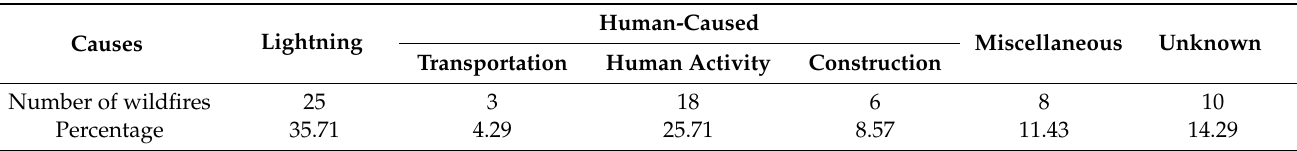
Figure 3. ( a ) Yearly frequency of wildfires and burned areas and ( b ) fire frequency by month in Plumas National Forest from 2016 to 2021. Table 1. Statistical summary of wildfire ignition causes in Plumas National Forest from 2016 to 2020. (2021 wildfires are under